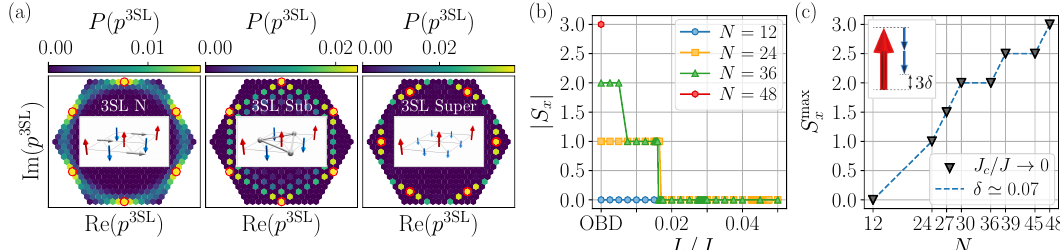
Figure 5: Cavity-induced OBD mechanism in the large coupling limit from the ef- fective spin model. (a) Sublattice polarization distribution of the complex order pa- rameter p 3SL for the normal, subradiant, and superradiant 3SL phases (from left to right) for N = 36 spins. The large value of 〈| p 3SL |〉 in all panels indicates strong 3SL order for all these phases, while the different positions of the maxima (indicated by the red circles) show that the ordering pattern for the superradiant phase differs from the others. The fluctuations around the maxima identify the strongly distinct nature of the unpolarized sublattice in the normal and subradiant 3SL phases. (b) The ground state S sector cascades from a N -dependent maximal value S max to zero x x / J is increased. (c) Maximal ground state po- in the 3SL subradiant regime when J c / J → 0, as a function of system size N . larization S max , achieved in the OBD limit J c x The dashed line shows the expected behavior for a polarization density δ (cid:39)